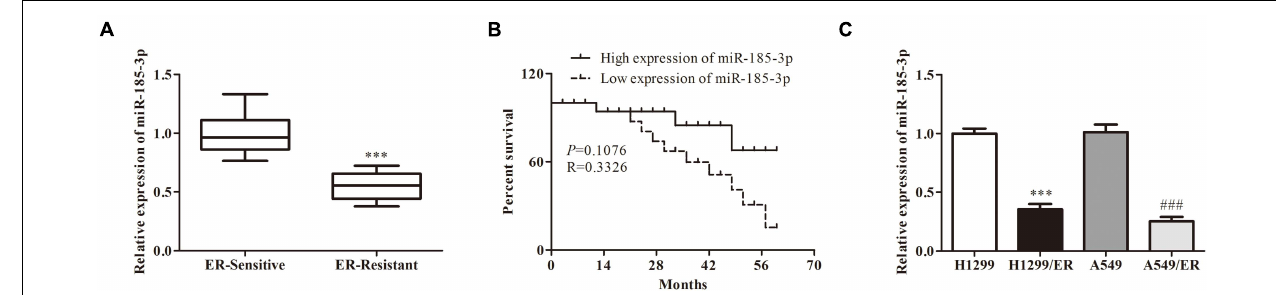
FIGURE 1 | The correlation of miR-185-3p with erlotinib (ER) resistance in ER-resistant cells and tissues. (A) The relative expression of miR-185-3p was determined by qRT-PCR in ER-sensitive and ER-resistant tissues. (B) The survival rate of patients with different levels of miR-185-3p. (C) The relative expression of miR-185-3p was determined by qRT-PCR in various lung cancer cell lines. Data were shown as mean ± SD. ∗∗∗ p < 0.001; ### p < 0.001.